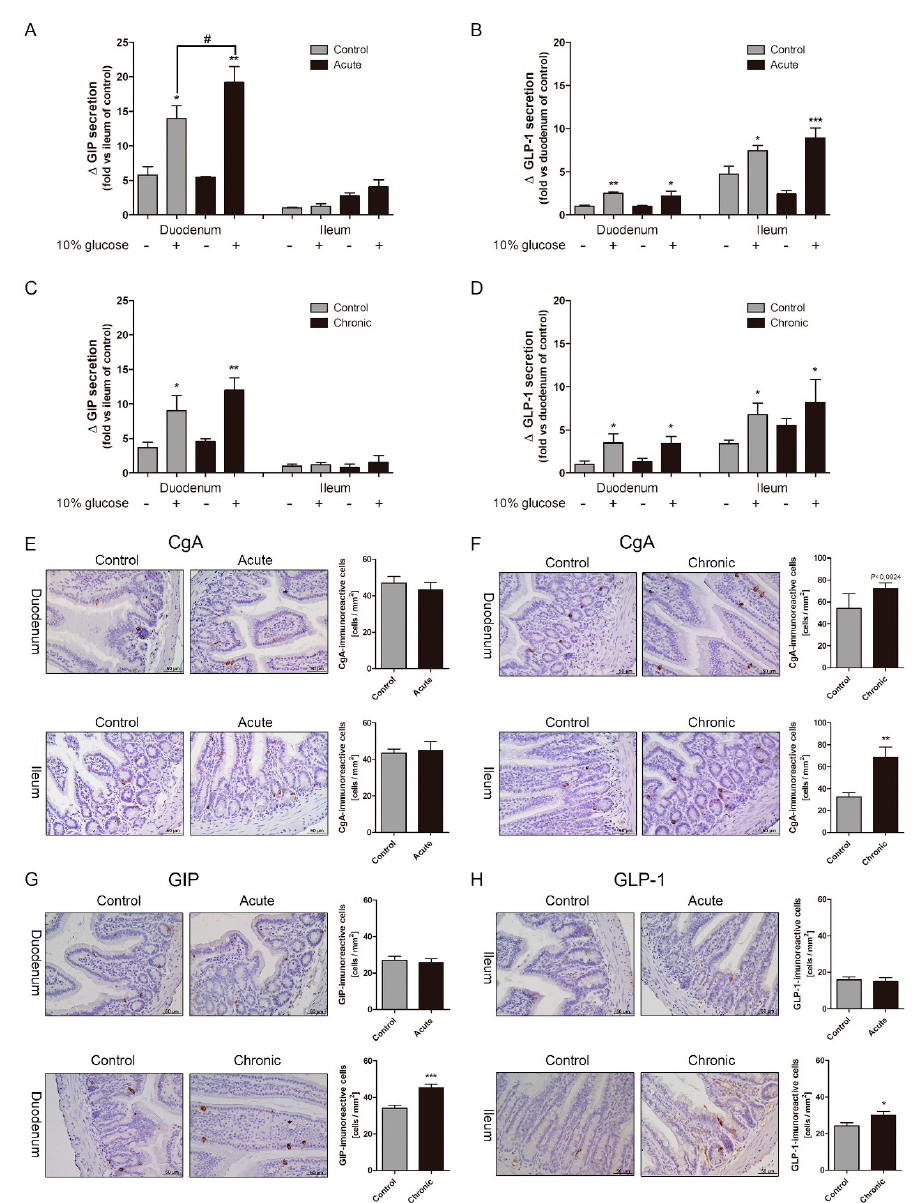
Figure 2. Gastrointestinal tract (GI) inflammatory conditions stimulate glucose-induced incretin secretion. Glucose-stimulated GIP secretion ( A ) and GLP-1 secretion ( B ) in the minced duodenum and ileum tissues of the acute group. Incretin secretion in response to 10% glucose in the chronic group ( C , D ). Comparison of the absence and presence of 10% glucose. * p < 0.05, ** p < 0.01, *** p < 0.001, n = 6 / group, Compared to the control group in presence of 10% glucose. # p < 0.05, Student’s t -test. The distribution of Chromogranin A (CgA), a representative enteroendocrine cell marker, in the acute ( E ) and chronic groups ( F ). GIP-positive spots in duodenum tissue ( G ) and GLP-1-positive spots in ileum tissue ( H ). Positive cells (brown spots). Graph shows mean ± SEM. * p < 0.05, ** p < 0.01, *** p < 0.001, Student’s t -test. Scale bars represent 50 μ m.